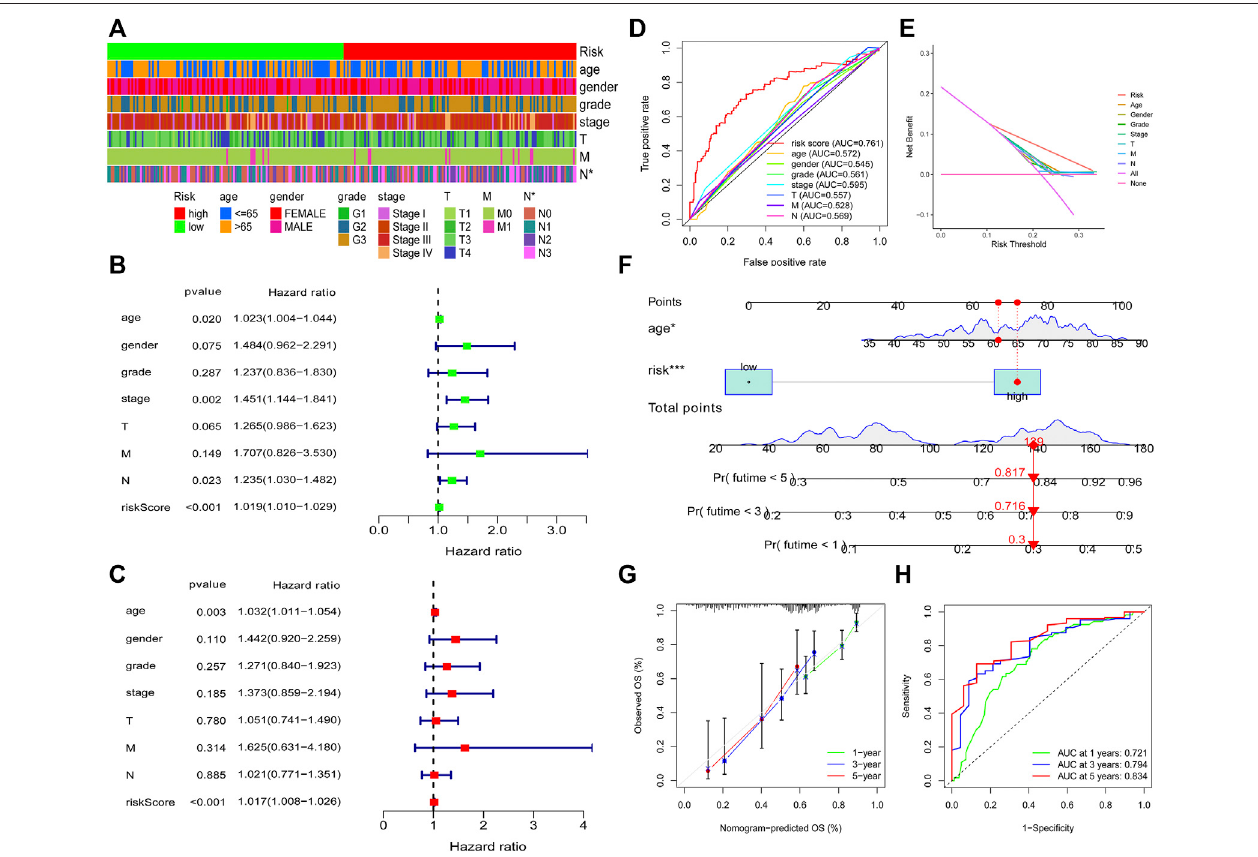
FIGURE 5 | Clinical application of the risk model. Correlation between the risk model and the clinicopathological characteristics of GC patients (A) . Univariate analysisandmultivariableanalysiswereconductedtoverifytheindependentprognosisfunctionofthemodel (B,C) .ROCandDCAcurveswereperformedtocon fi rmthe superiority of the risk score in clinical application (D, E) . The nomogram was plotted to obtain the predicting survival time of GC patients (F) . A calibration curve was utilized to assess the accuracy of the model in predicting patients ’ survival time (G) . The AUC value of the nomogram (H)